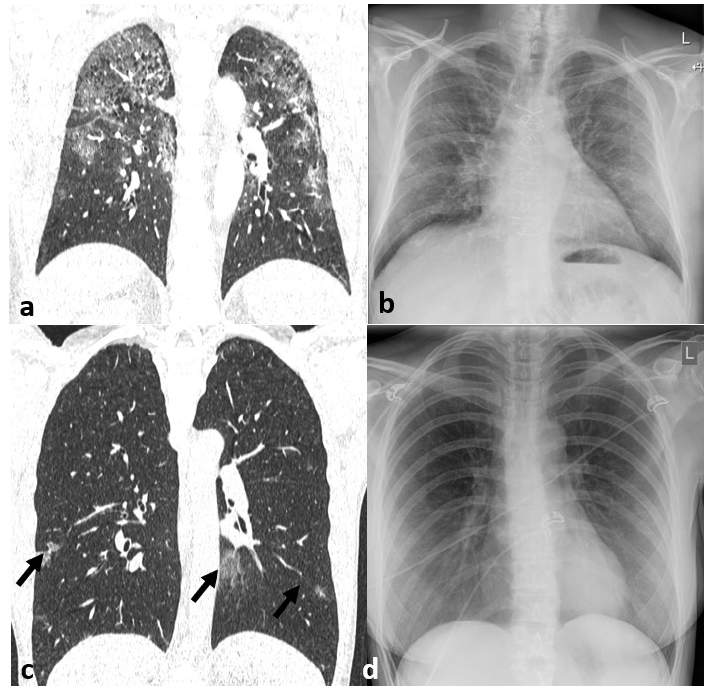
Figure 3. ( a , b ) 66-year-old male COVID-19 patient presenting with ground-glass opacification (GGO) predominantly in the upper lobes on ( a ) chest computed tomography comprising between 25 and 50% of the lung parenchyma. ( b ) Conventional radiography which was obtained 4 h before CT showed only subtle opacification in the left upper lobe and probably pneumonia a ff ecting less than 25% of the lung parenchyma was given. ( c , d ) 55-year-old female COVID-19 patient presenting with subpleural ground-glass opacification (GGO) on ( c ) chest computed tomography (arrows) a ff ecting less than 25% of the lung parenchyma. ( d ) Conventional radiography that was obtained 2 h before CT showed no suspicious changes and was rated as